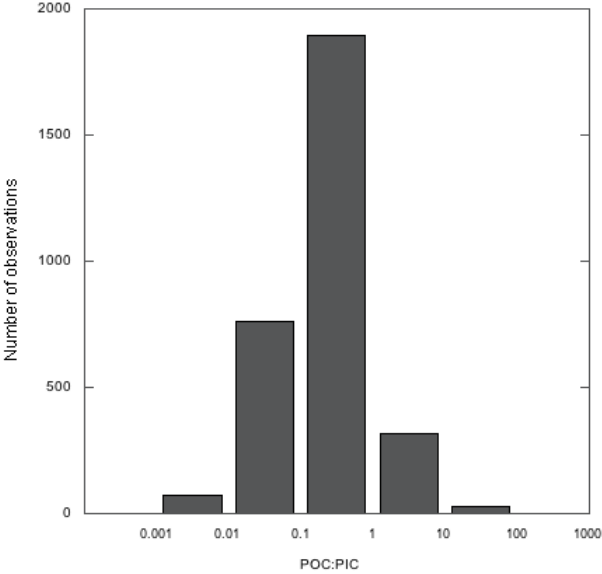
Figure 4. Average PIC stocks (MgPICha − 1 ) ± SE by 10 ◦ latitude bins. The number above each bar indicates the number of observa- tions reported for each latitude bin.